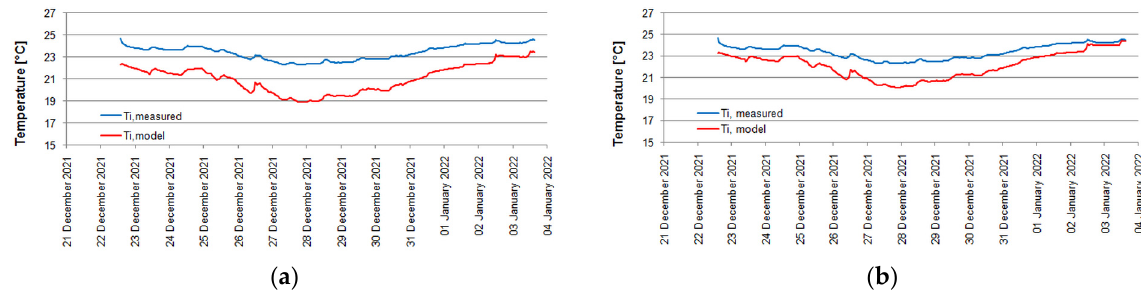
Figure 8. Measured and simulated indoor air temperature: ( a ) Case 1; ( b ) Case 2. Table 3. Statistical indicators for indoor air simulation obtained for both cases. Table 3. Statistical indicators for indoor air simulation obtained for both